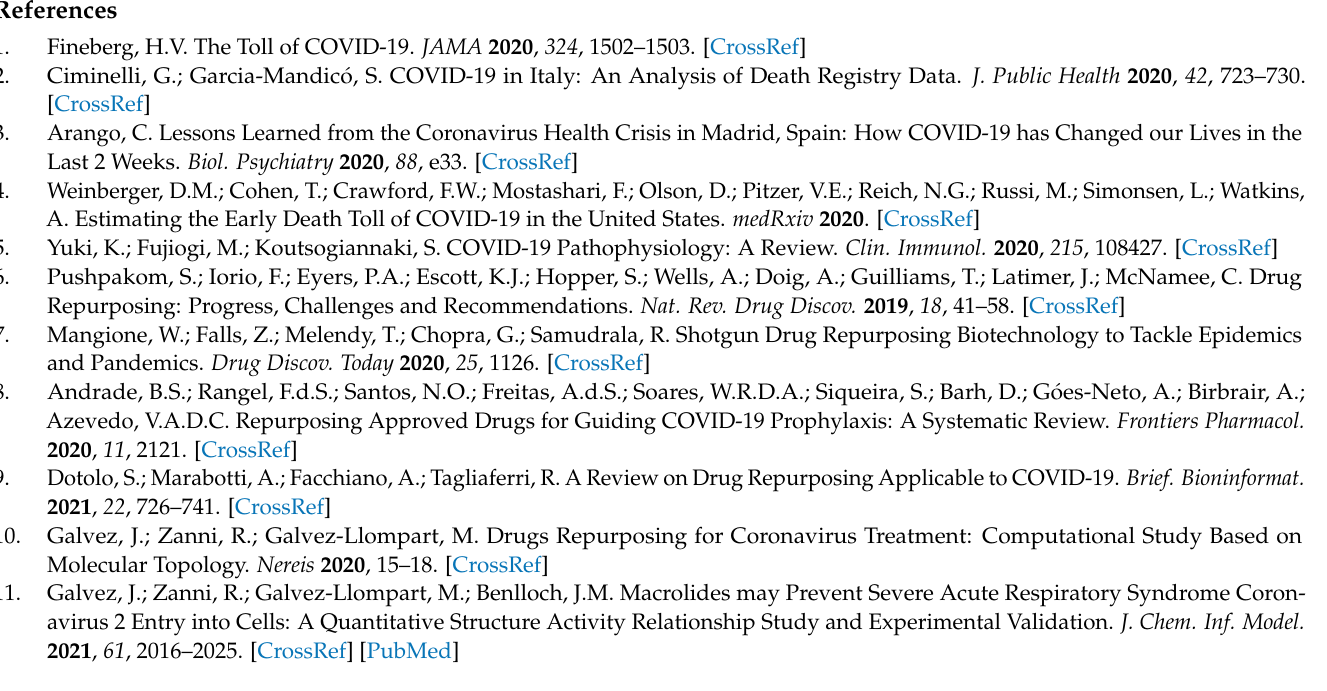
Table S3: ANNClass_6LU7 training set: compounds identification, 6LU7 Mpro docking score,